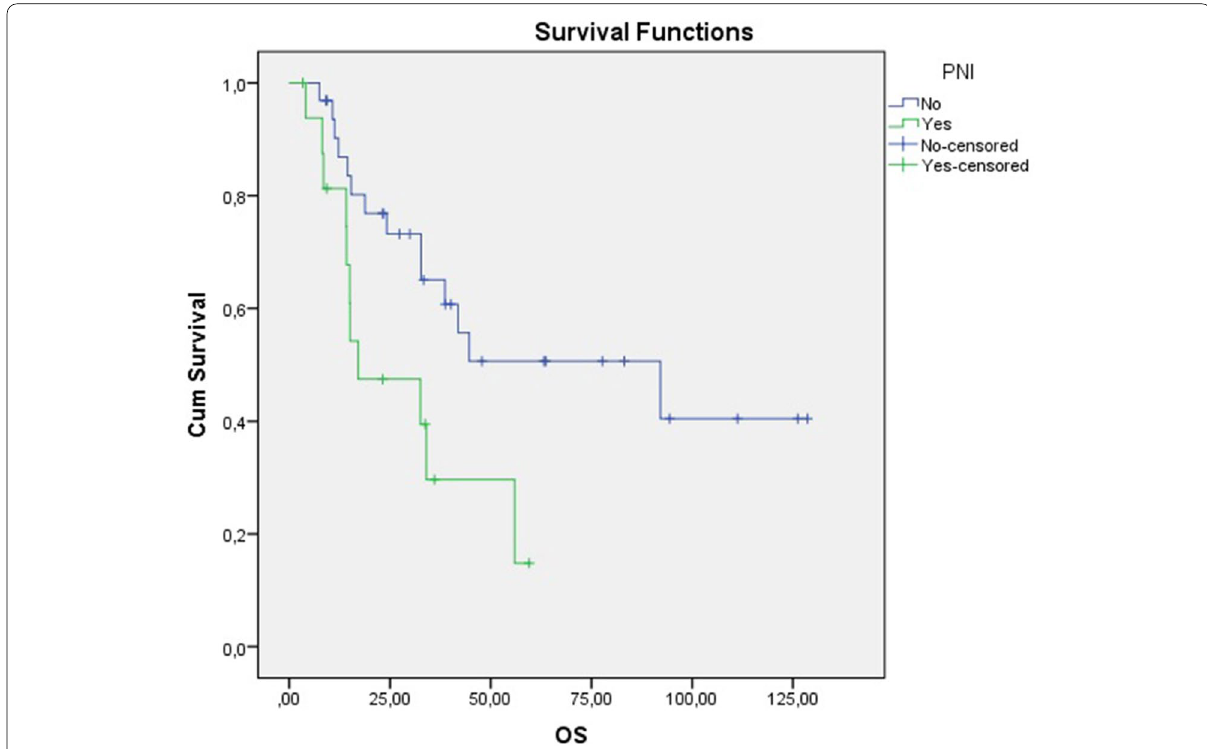
Fig. 3 Kaplan–Meier curve of OS based on PNI